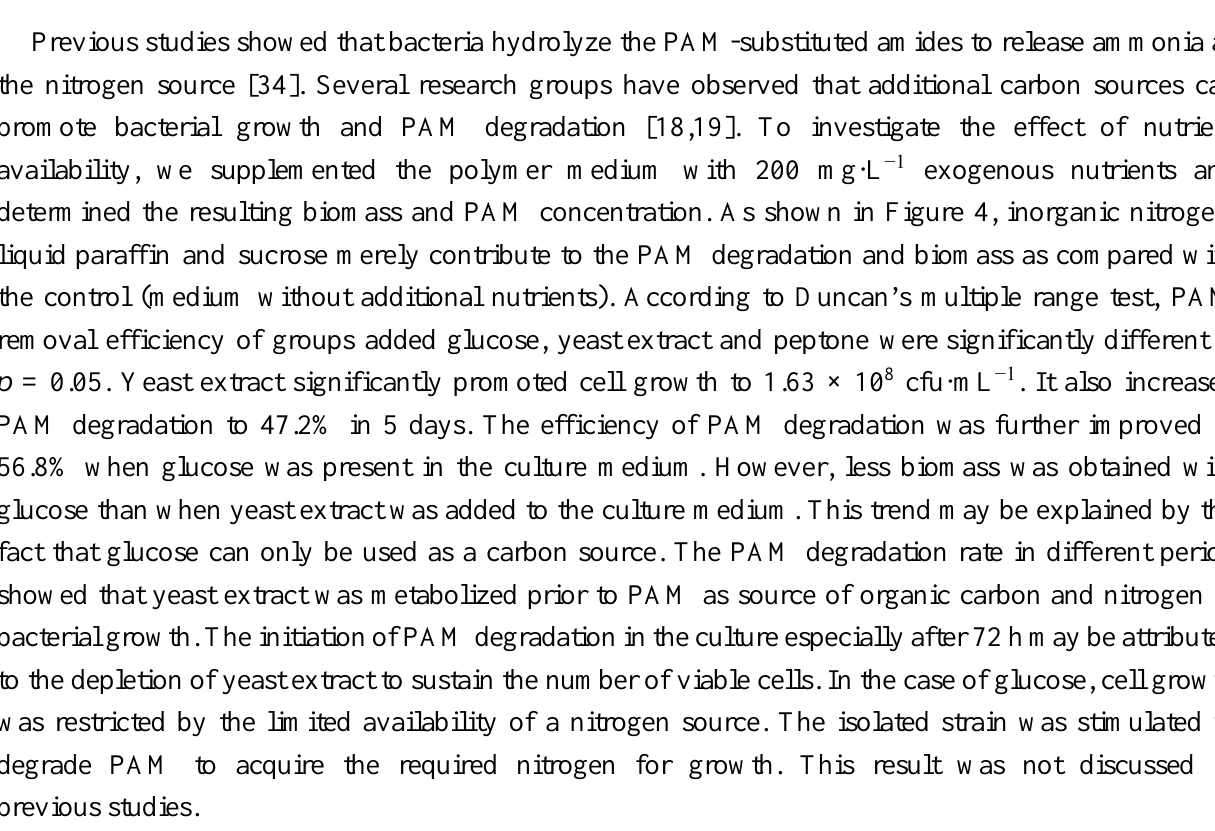
Figure 3. Effect of temperature ( a ) and pH ( b ) on PAM removal efficiency and viable cell